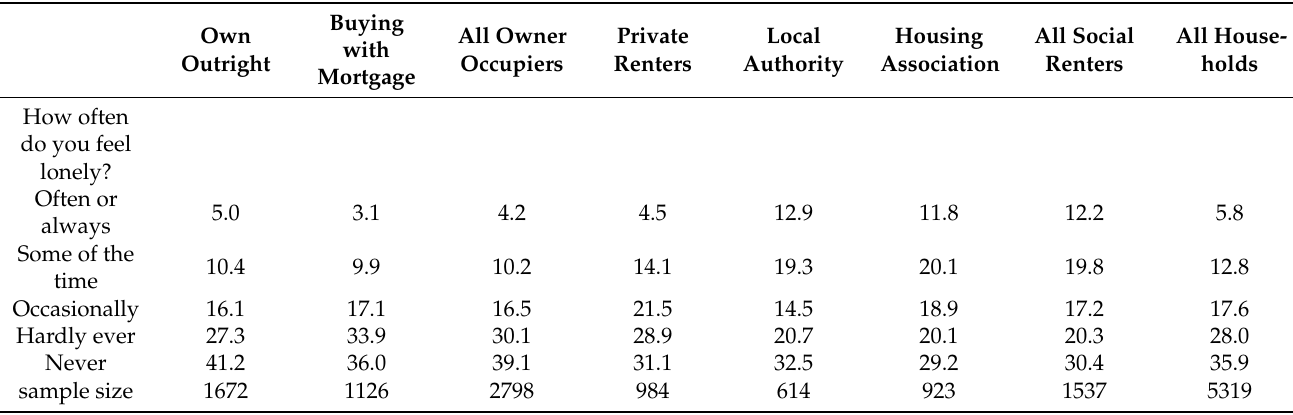
Table A19. Loneliness, by tenure, 2019–2020